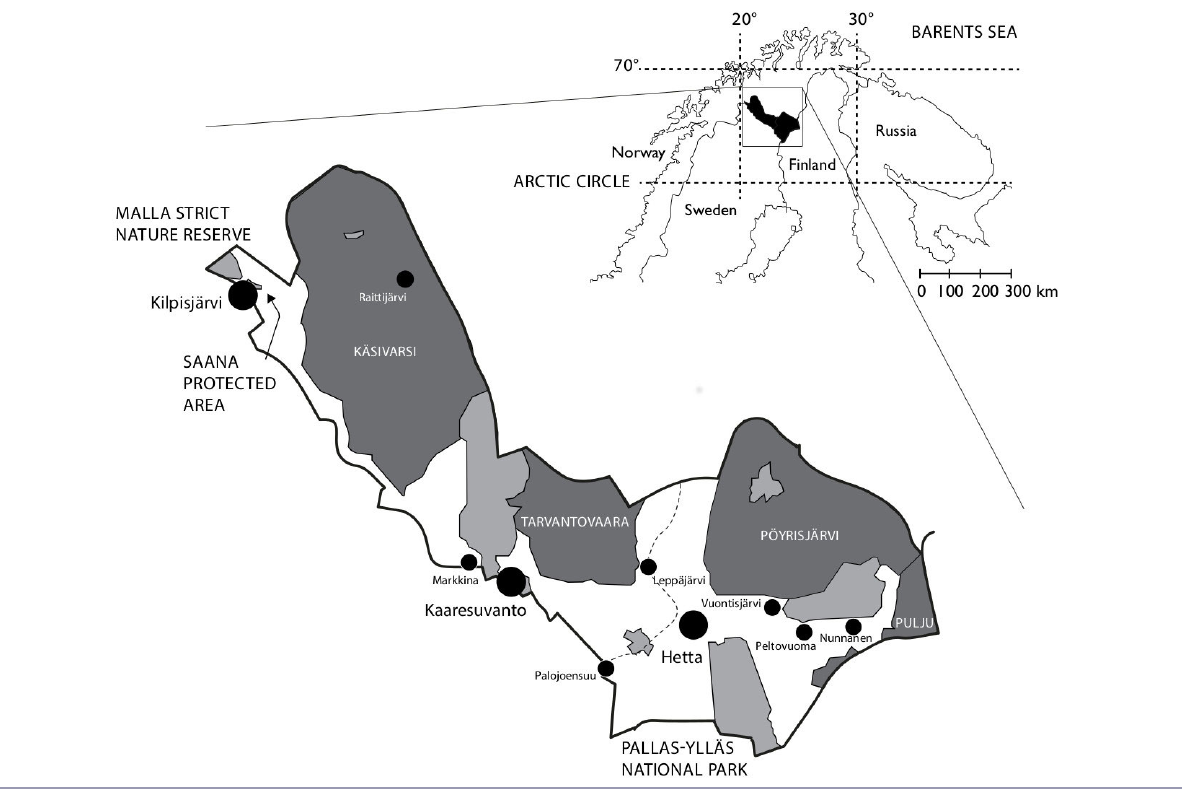
Fig. 1 . Research area and wilderness and conservation areas of Eanodat. The Käsivarsi Wilderness Area consists of 264,950 hectares, and the Saana Area 12,297 hectares. The Pulju Wilderness Area is 69,206 hectares in area, of which 30% is located in the municipality of Eanodat. Käsivarsi and Saana are pasture areas for the Käsivarsi reindeer herding cooperative. The Pulju Wilderness Area serves as winter pastureland for the Näkkälä reindeer herding